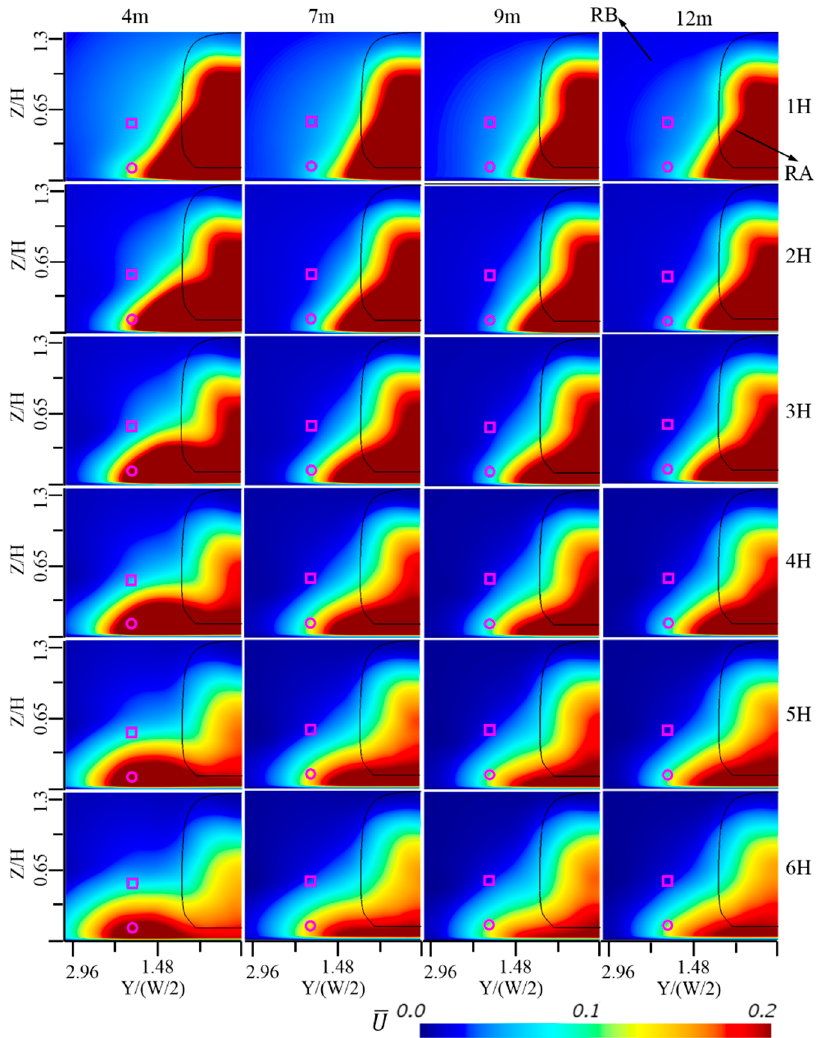
Figure 17. Time-averaged U of vertical planes 1 H , 2 H , 3 H , 4 H , 5 H , and 6 H from tail of train (hollow pink square: platform position; hollow pink circle: trackside position.).